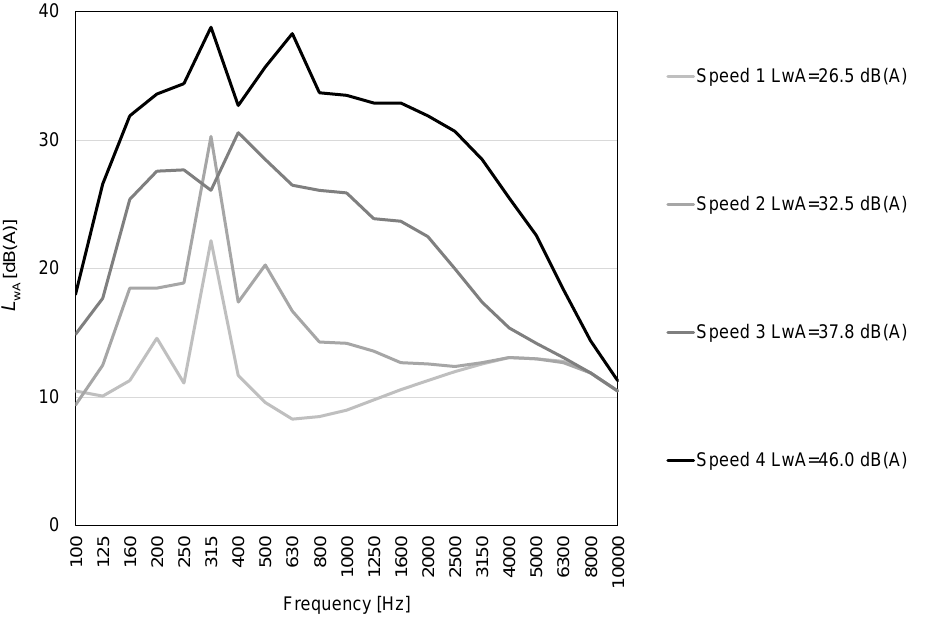
Figure 10. CM CMV A-weighted sound power levels L wA .